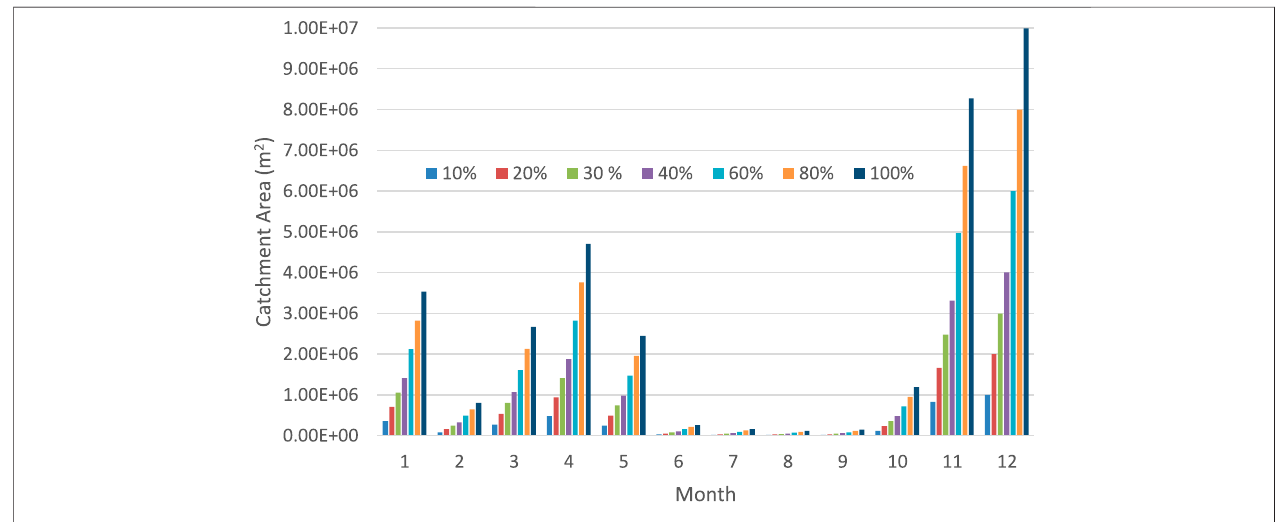
FIGURE 4 | Catchment area for the rainwater harvesting system considering the precipitation and demand covering of fresh water.